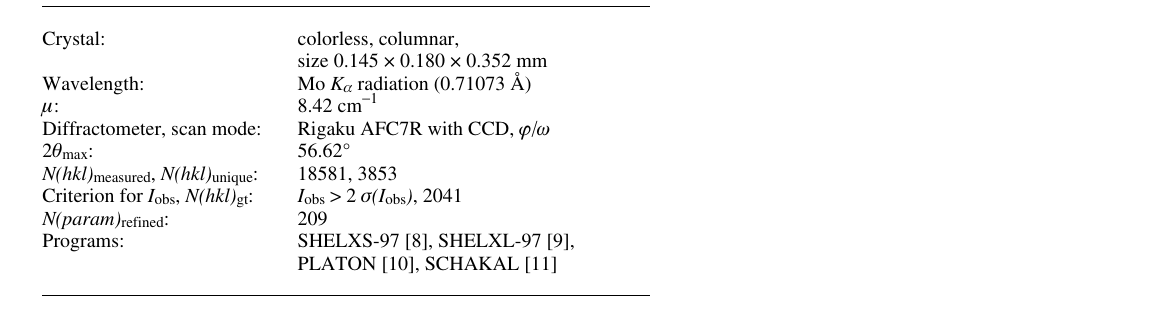
Table 1. Data collection and handling.